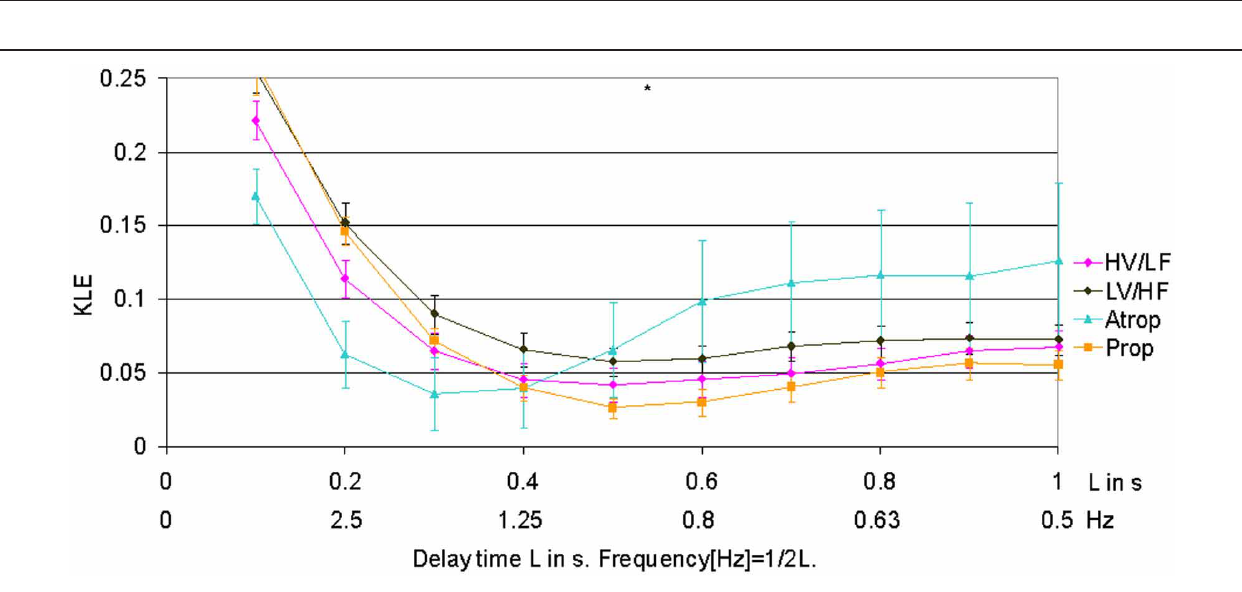
FIGURE 2 | Focus on the short-term time scale KLE segment. This figure demonstrates changes induced by pharmacologic blockades on short-term time scale fHRV complexity measured by KLE. N = 6. ∗ p < 0 .